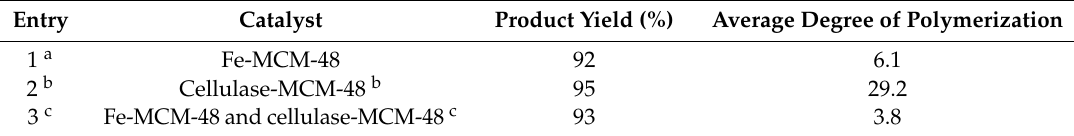
Table 2. Results of the chitosan degradation